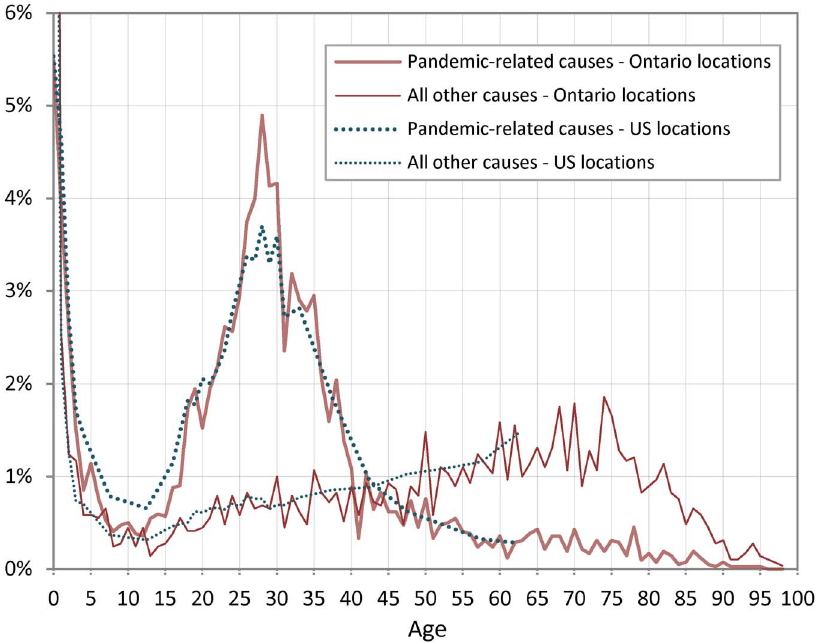
Figure 4. Percentages of deaths by age from pandemic-related causes and from all other causes in Ontario and US locations, September to December 1918. && Key for Figure 4: Yearly age-specific deaths counts were available from age 0 to 4 and from 18 to 31 for the US locations in the special tables that were tabulated for these locations in 1920 (27); outside these ranges, death counts were only available for collapsed age-groups (i.e., 5–9, 10–14, 15–17, 32–34, 35–39, 40–44, ..., and 60–64). We divided the number of deaths in the interval by its length and plotted the obtained number at the midpoint value of the interval. Deaths above age 65 were not available by age or age-groups for the U.S. locations. Ontario locations: Toronto, Hamilton, Ottawa, London, and Welland & Lincoln; US locations: Philadelphia, Indiana, and Kansas.